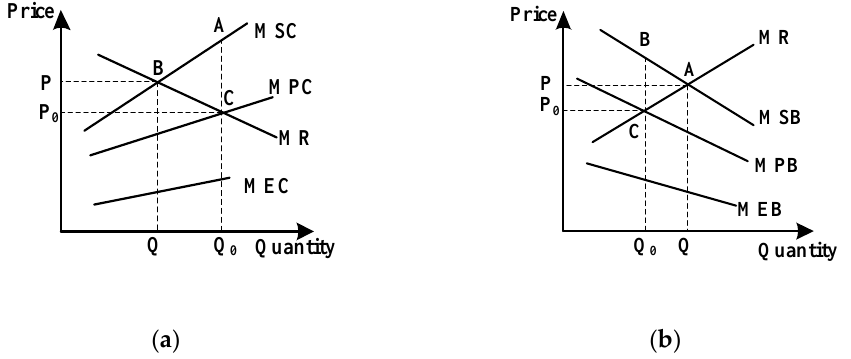
Figure 7. Externality schematics: ( a ) Negative externality, MSC represents marginal social cost, MPC represents marginal private cost, MR represents marginal requirement, and MEC represents marginal external cost. ( b ) Positive externality, MSB represents the marginal social benefits, MPB represents the marginal private benefits, and MEB represents the marginal external benefits.